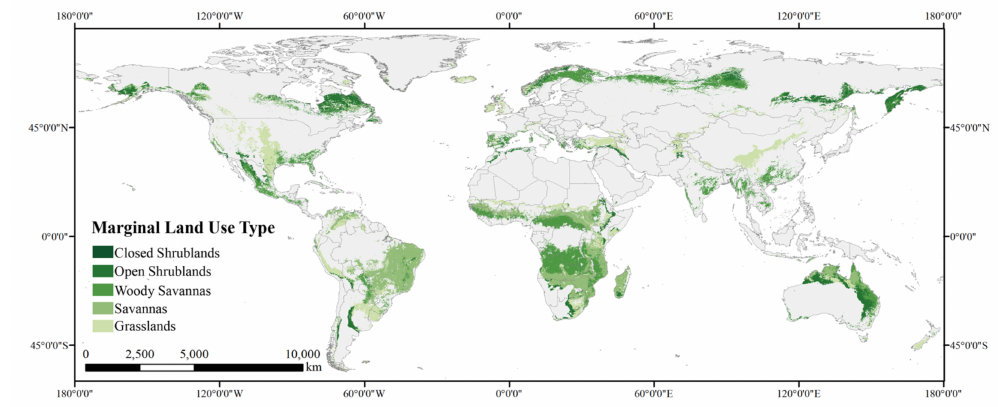
Figure 5. Global distribution of the estimated potential marginal land resources supporting giant silvergrass cultivation.